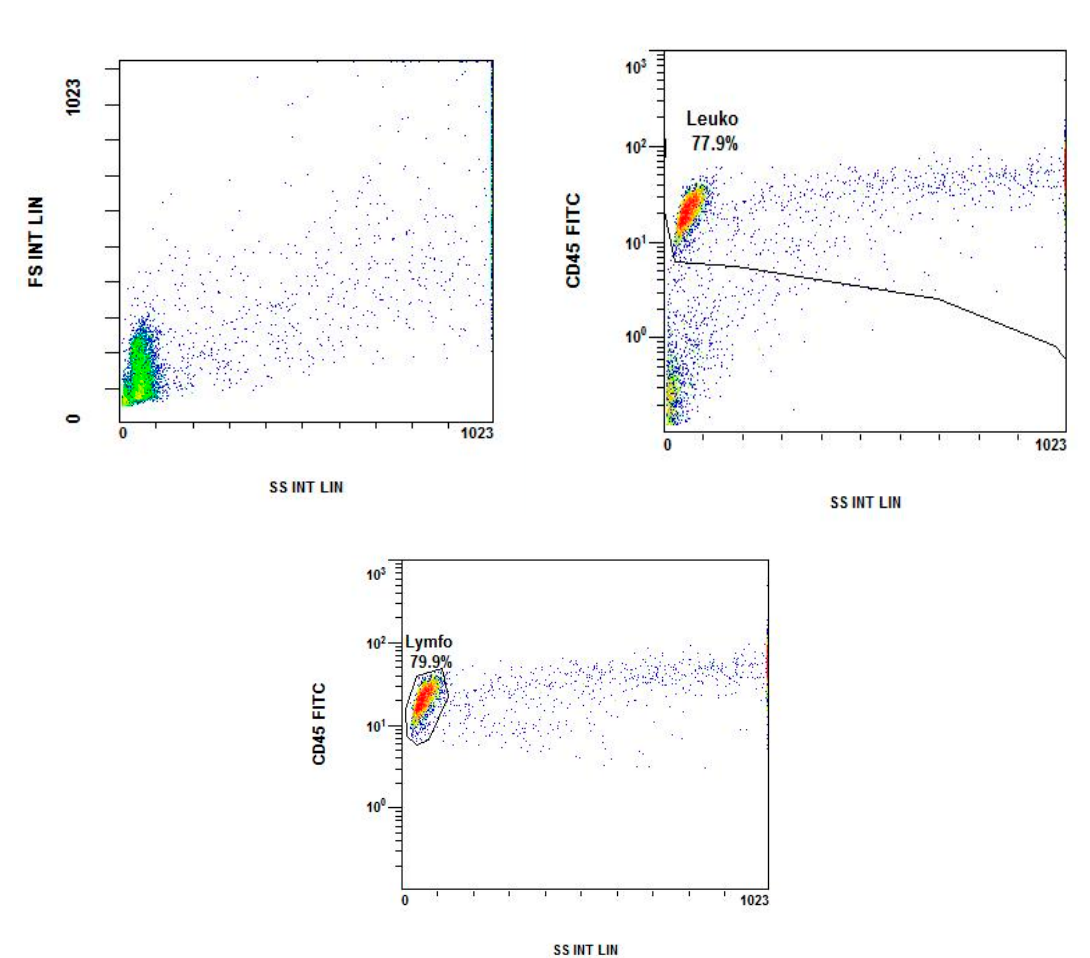
Figure A1. Immunophenotyping of lymphocytes.